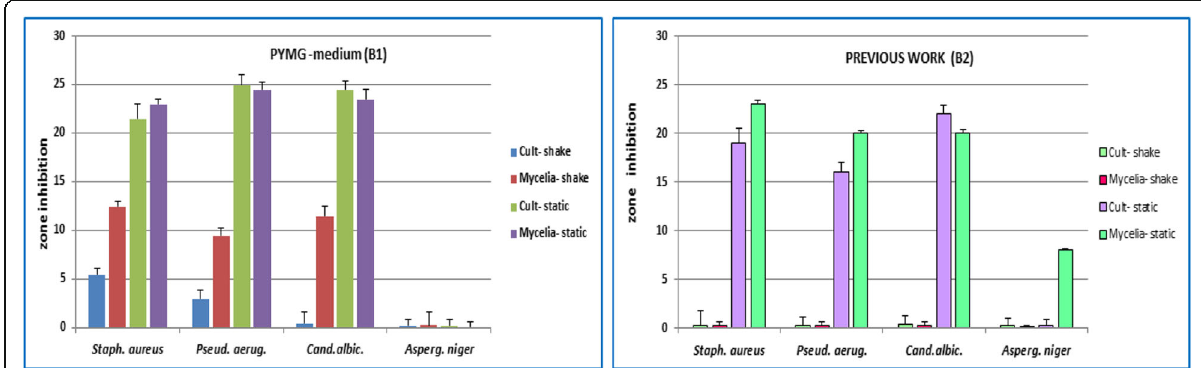
Fig. 2 Demonstrative antimicrobial comparison between PYMG medium (5% glucose, distilled water) and previous work medium (10% glucose, seawater)